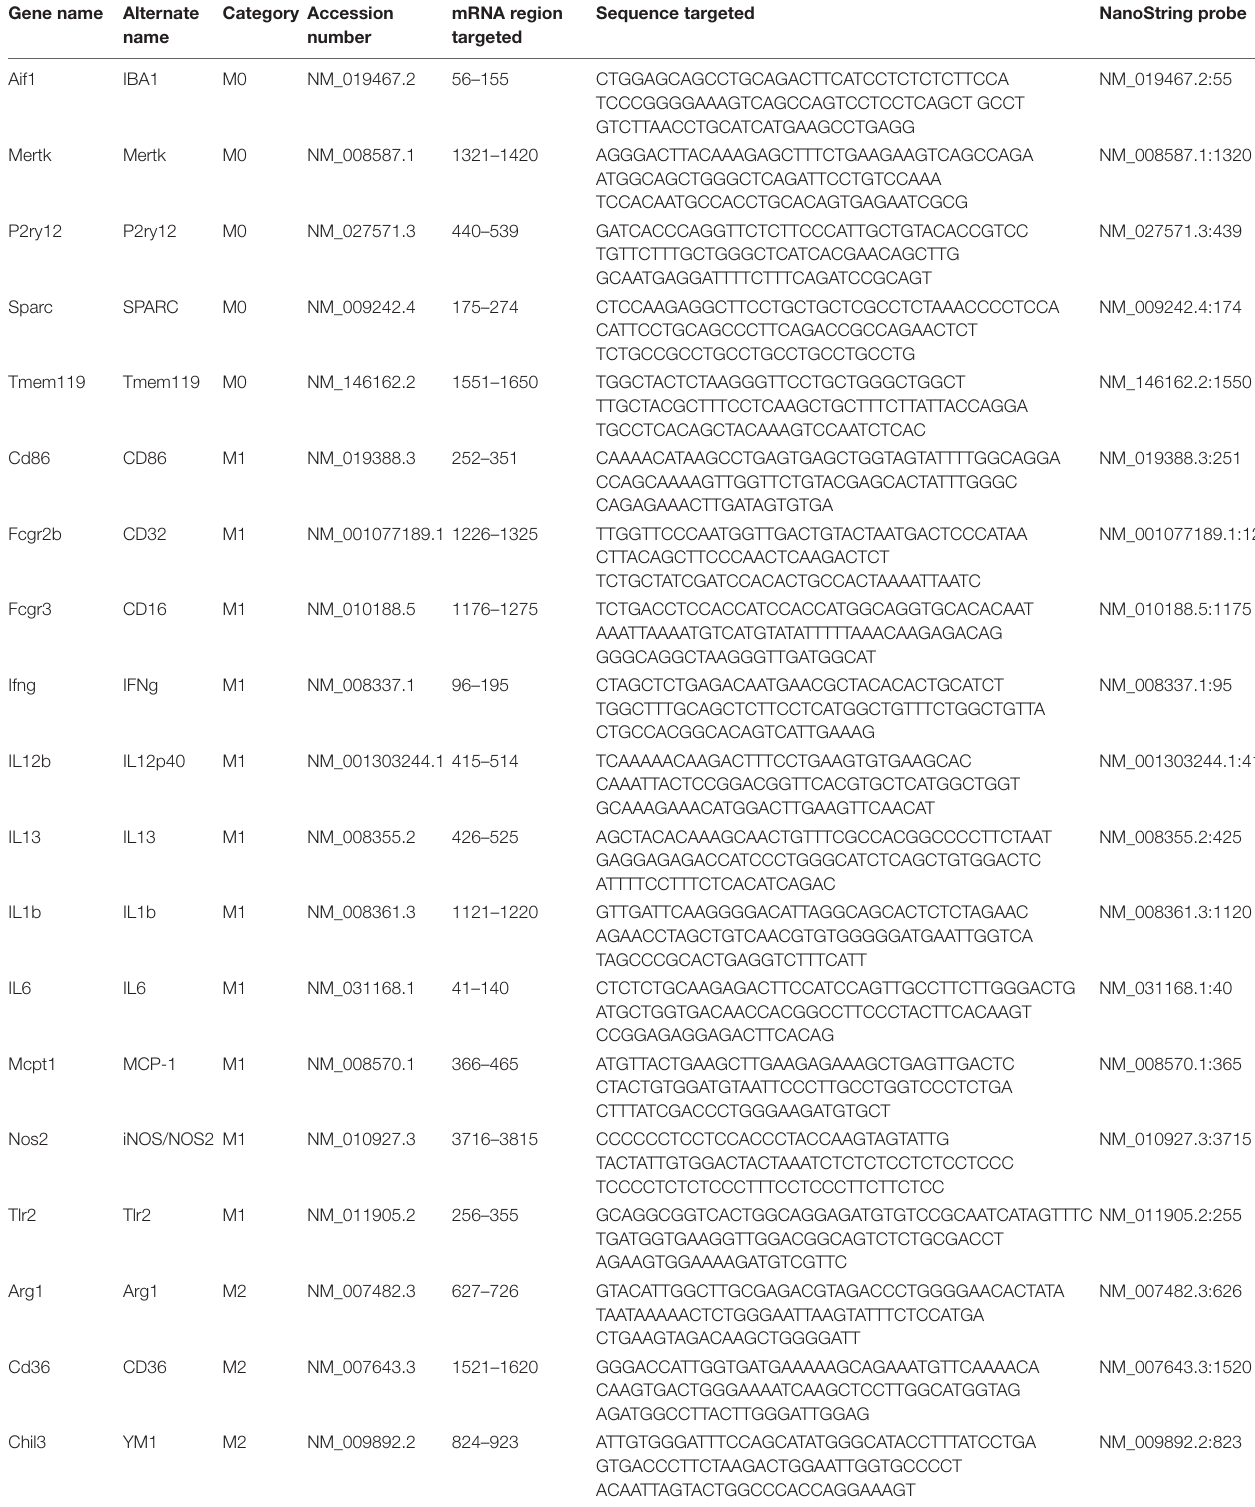
TABLE 2 | Gene targets and probes for NanoString